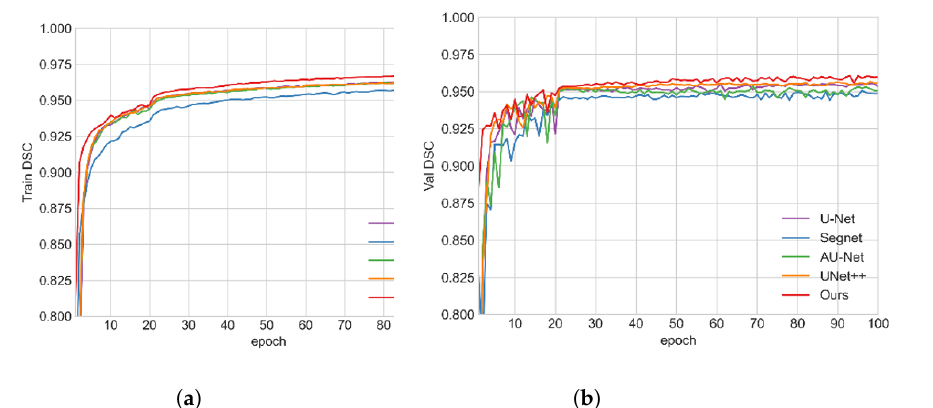
Figure 7. Training and validation DSC curves of Verte-Box and other algorithms. ( a ) Training curve; ( b ) validation curve.